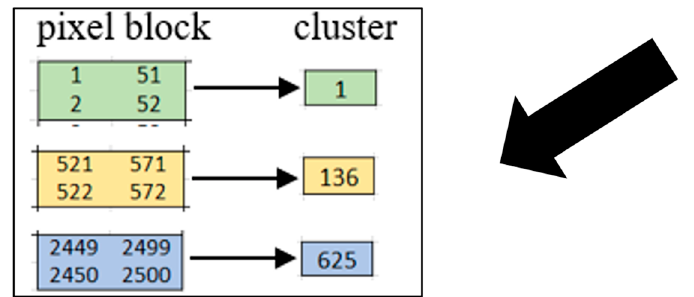
Figure 2. Conversion between pixels and clusters, showing the whole picture of the pixels and the demonstration of conversion process.